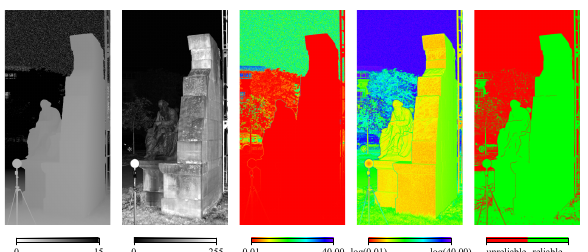
Figure 2. Visualization for linearity L λ , planarity P λ , scattering S λ , the classification of each pixel according to its local behavior (linear: red; planar: green; scattered: blue) and the derived binary confidence map (from left to right).